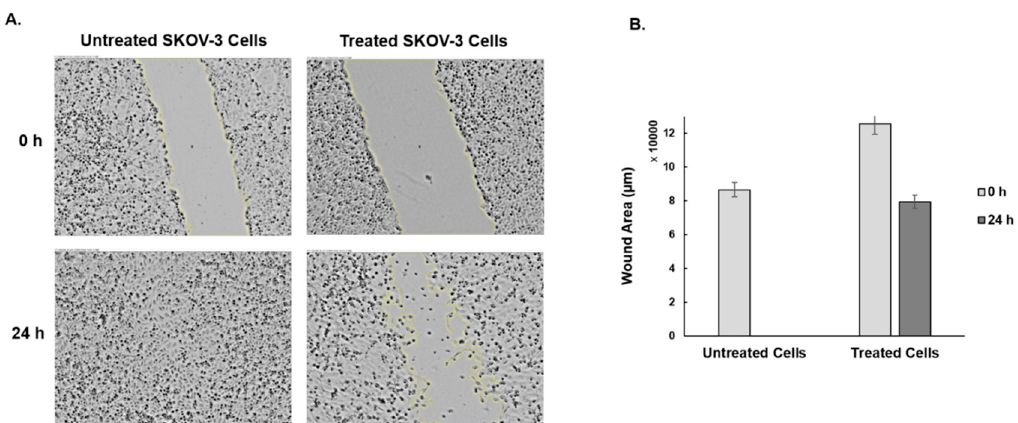
Figure 8. Wound healing assay of SKOV-3 cells with and without curcuminoids (30 µM) treatment. ( A ) Representative microscopic images show scratch wounds at 0 and 24 h. ( B ) The wound area was quantified by automated image J and the results confirm the ability of curcuminoids to inhibit SKOV-3 cell